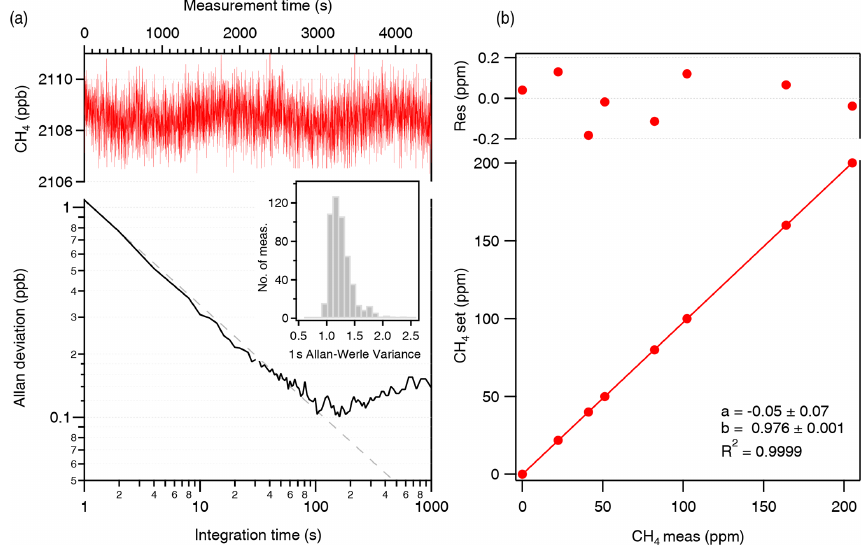
Figure 4. (a) Allan–Werle deviation plot as a function of integration time. The intercept at 1s corresponds to 1 . 1ppb precision, which continues to improve for 100s reaching a value of 0 . 1ppb. The inset is a histogram plot showing the distribution of the Allan deviation values at 1s over multiple measurements. (b) Calibration and linearity test of the CH 4 sensor.